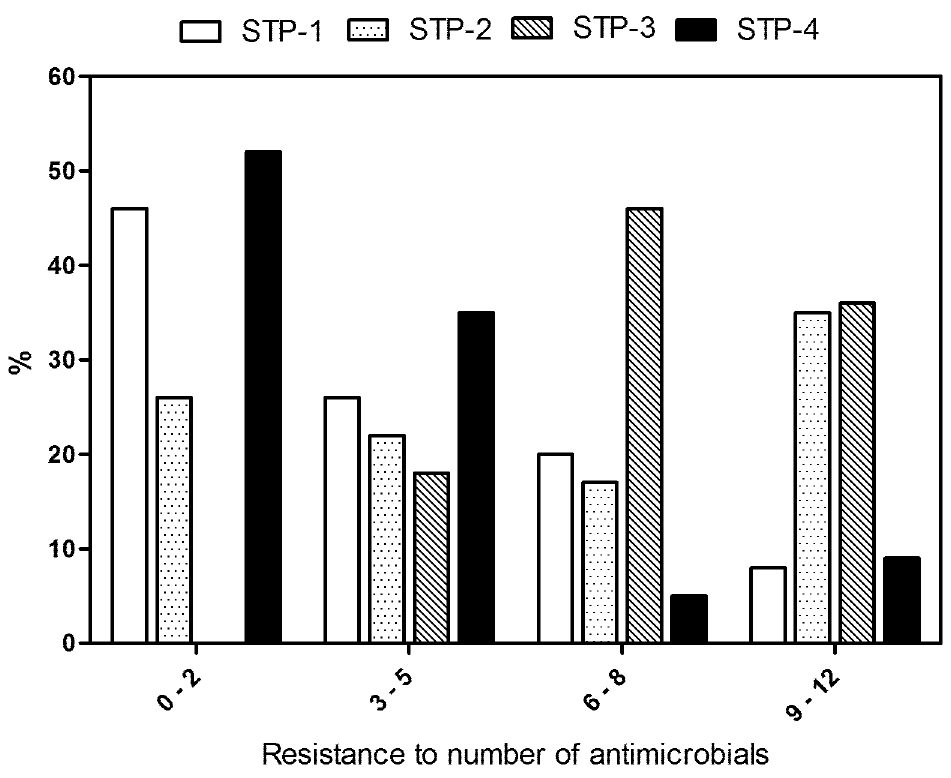
Fig 4. The number of drugs to which E . coli isolates from four different sewage treatment plants (STPs) in South India showed antimicrobial resistance. The X-axis indicates the number of resistant- antimicrobials of E . coli isolates. The Y-axis represents the percentage of the resistant E . coli isolates. Data for STP-1, -2 and -3 were retrieved from Akiba et al., 2015.